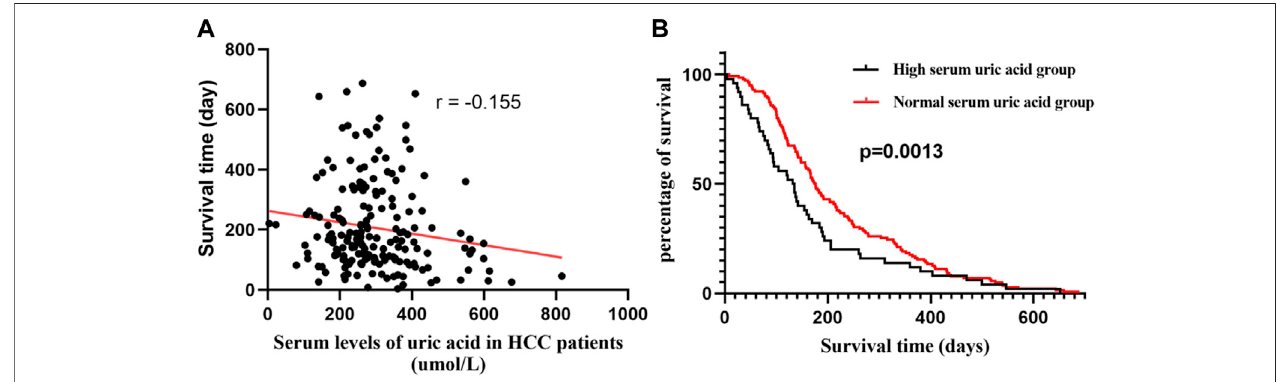
FIGURE1| TheresultsofretrospectiveanalysisinadvancedHCCpatients. (A) Correlationofserumuricacidandsurvivaltime. (B) Kaplan – Meiercurvesofhighand normal serum uric acid (Gehan-Breslow-Wilcoxon test, p (cid:1) 0.0013).